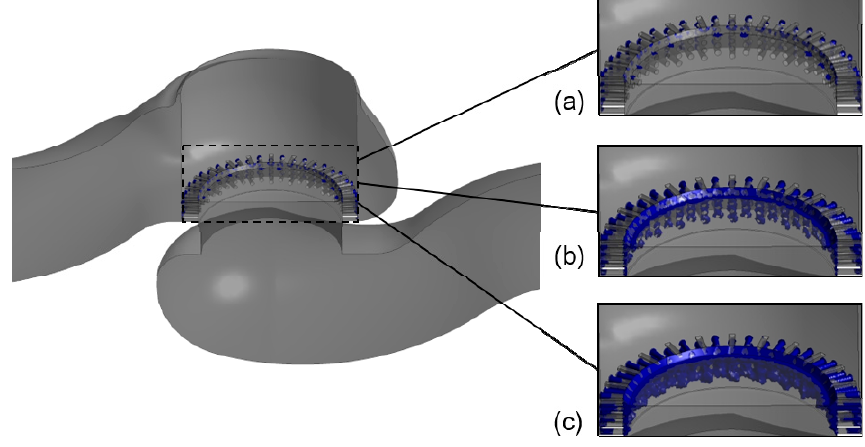
Figure 12. Vapor distributions inside the sleeve regulating valve for different pressure difference with the valve core displacement of 30 mm ( a ) 2 MPa; ( b ) 5 MPa; ( c ) 8 MPa.